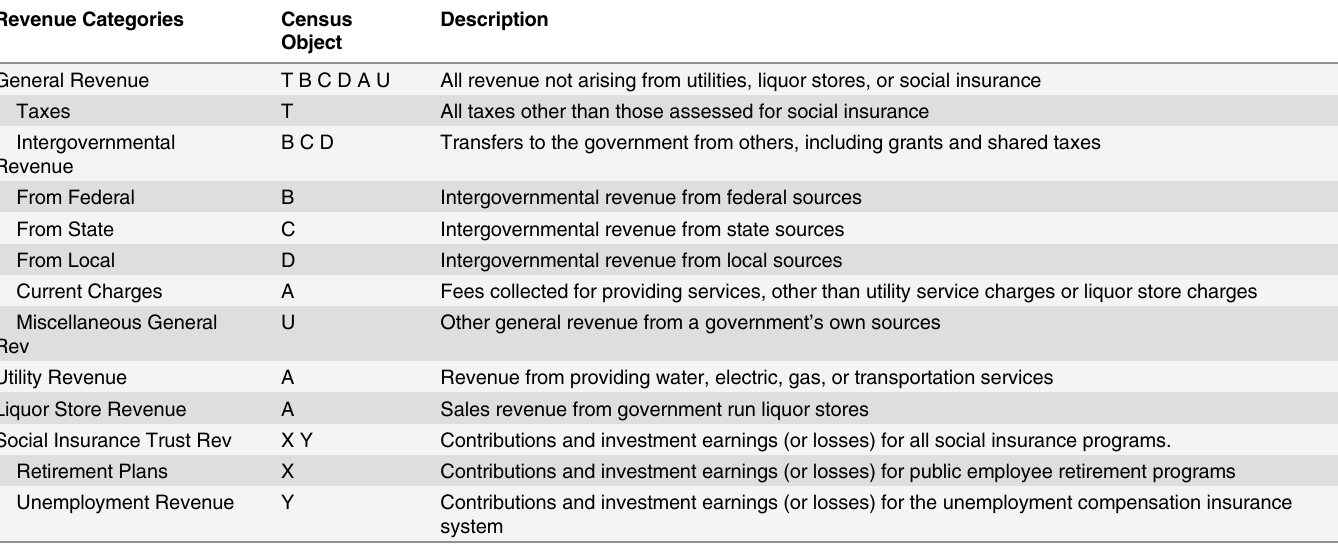
Table 1. Revenue